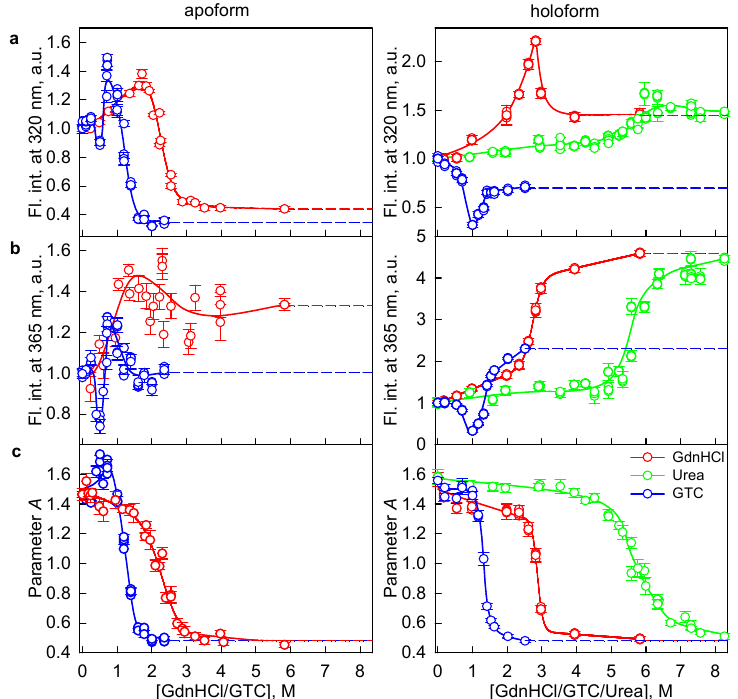
Figure 4. Unfolding of iRFP713 in the apoform (left panels) and holoform (right panels) induced by different chemical denaturants. ( a , b ) Changes in the tryptophan fluorescence intensity at an excitation wavelength of 295 nm and registration wavelengths of 320 and 365 nm. The values of fluorescence intensity I 320 and I 365 were normalized to unity at zero concentration of denaturants. ( c ) Changes in the parameter A = I 320 / I 365 at an excitation wavelength of 295 nm. The values of the recorded characteristics for iRFP713 unfolding induced by GdnHCl, GTC and urea are represented by red, blue, and green circles, respectively. The measurements were performed after 24 h incubation of the native protein in the presence of denaturants. Error bars are s.e.m., n = 3.